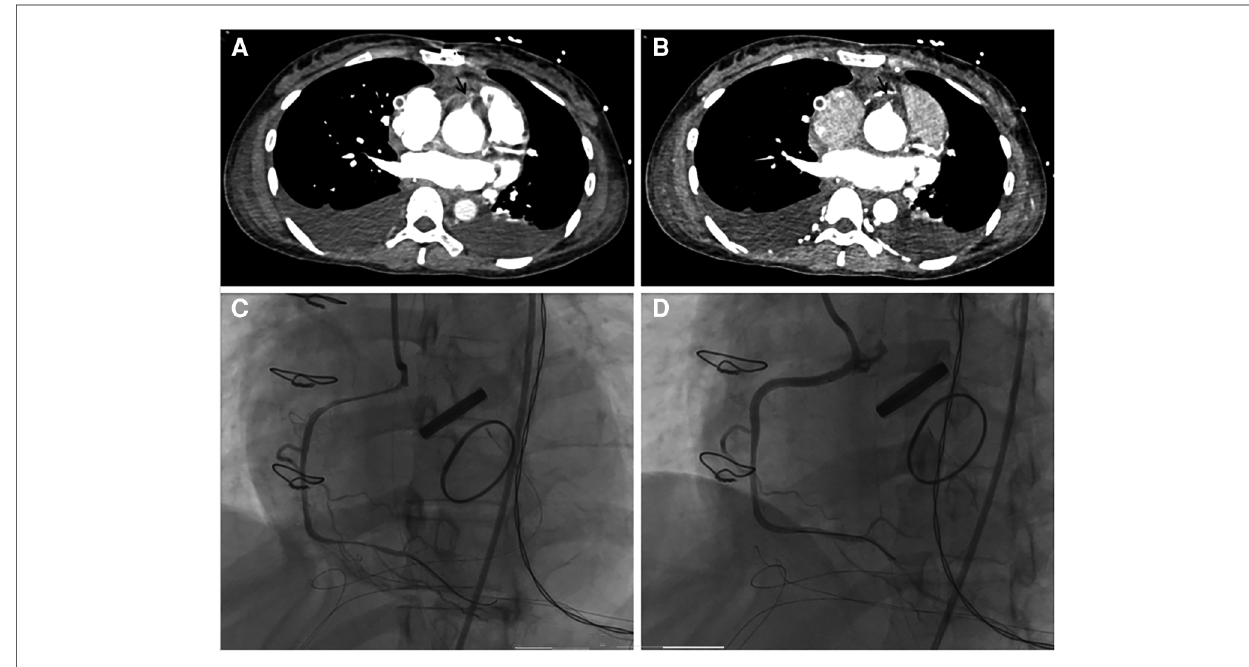
FIGURE 1 ( A,B ) pulmonary artery computed tomography angiography showed occlusion of the initial of the right coronary artery (black arrow). ( C ) Coronary angiography revealed occlusion of the right coronary artery (RCA) ostium, which was signi fi cantly improved after percutaneous coronary intervention ( D